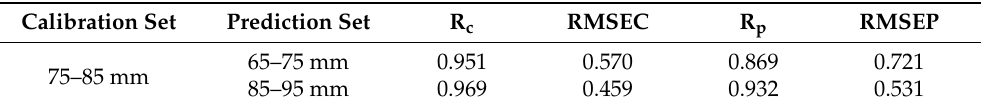
Table 5. PLSR results were established after the spectra correction.